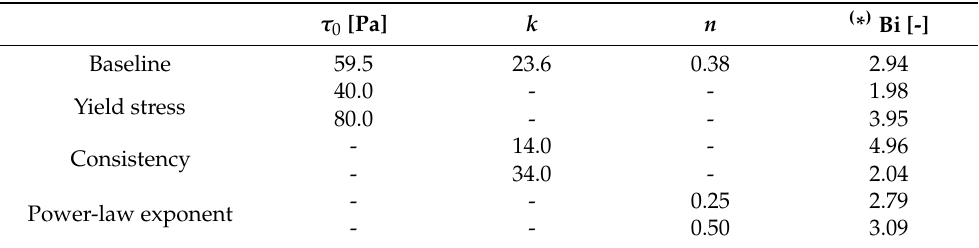
Table 4. Different rheological properties. (*) Bi is calculated for the plate immersion velocity of 1 mm/s. (-) refers to the same rheological property as the “Baseline” measured property.